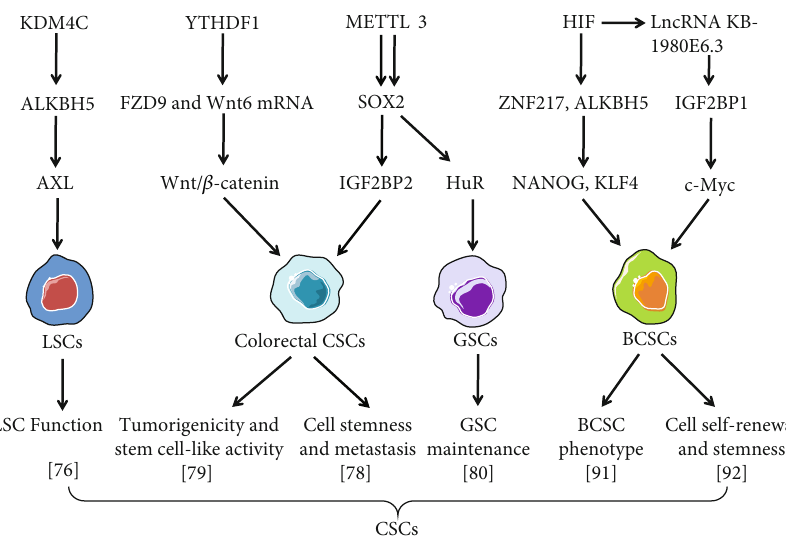
Figure 4: The schematic of interplays between m 6 A modulators and multiple factors in regulation of di ff erent CSC phenotypes, tumorigenicity, and